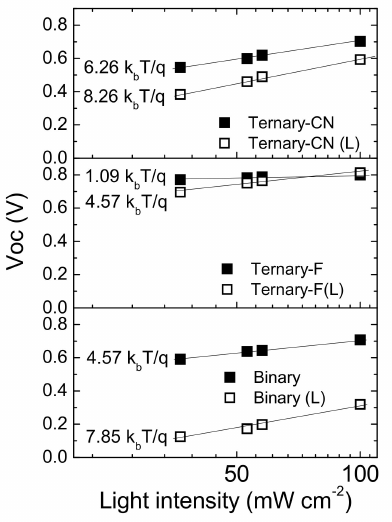
Figure 7. Light intensity vs. V OC plots for Binary, Ternary-F, and Ternary-CN before and after the light-soaking